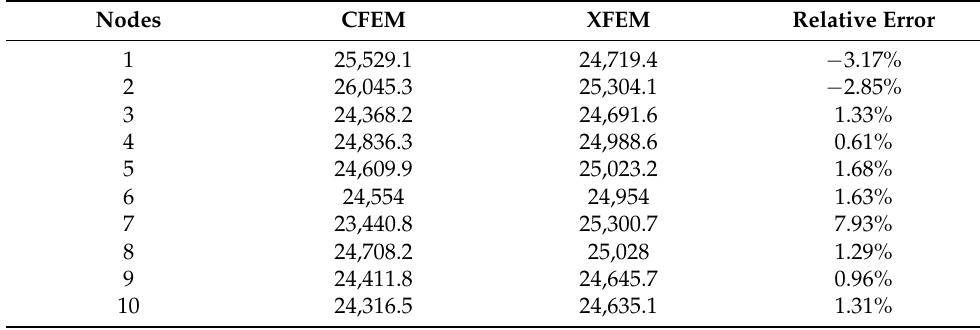
Table 5. Contrast of the results of nodes near interface.